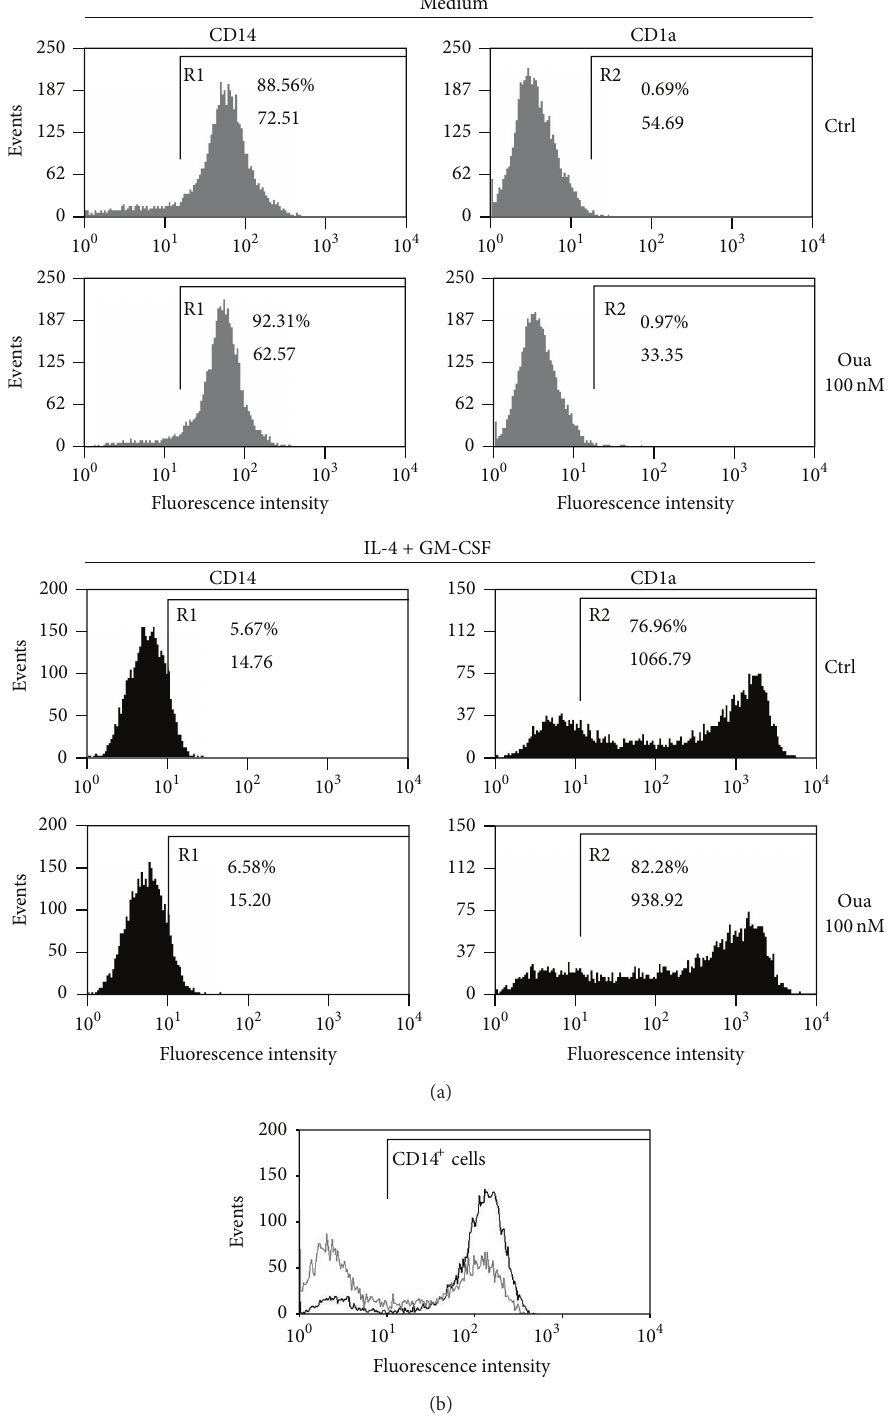
Figure 1: CD14 and CD1a expression patterns on monocytes cultured with Ouabain (Oua) prior to differentiation into dendritic cells. (a) Cells were incubated with medium in the presence or absence of 100nM Oua for 24 h and then with medium or IL-4 + GM-CSF (50ng/mL) for 5 days to allow monocyte differentiation into DC. Following this period, CD14 and CD1a expression was analyzed by flow cytometry. Representative histograms of 4 independent experiments showing CD14 and CD1a expression patterns in cells incubated only with medium, IL-4 + GM-CSF, and in cells treated previously with 100nM Oua. R1 and R2 regions comprise positive cells for CD14 and CD1a, respectively. The percentage of positive cells and mean fluorescence intensity is indicated in each histogram. (b) Monocytes were incubated for 24 h with 100nM Oua. Representative experiment showing CD14 expression patterns in control cells (black histogram) and in cells treated with 100nM Ouabain for 24 h (gray